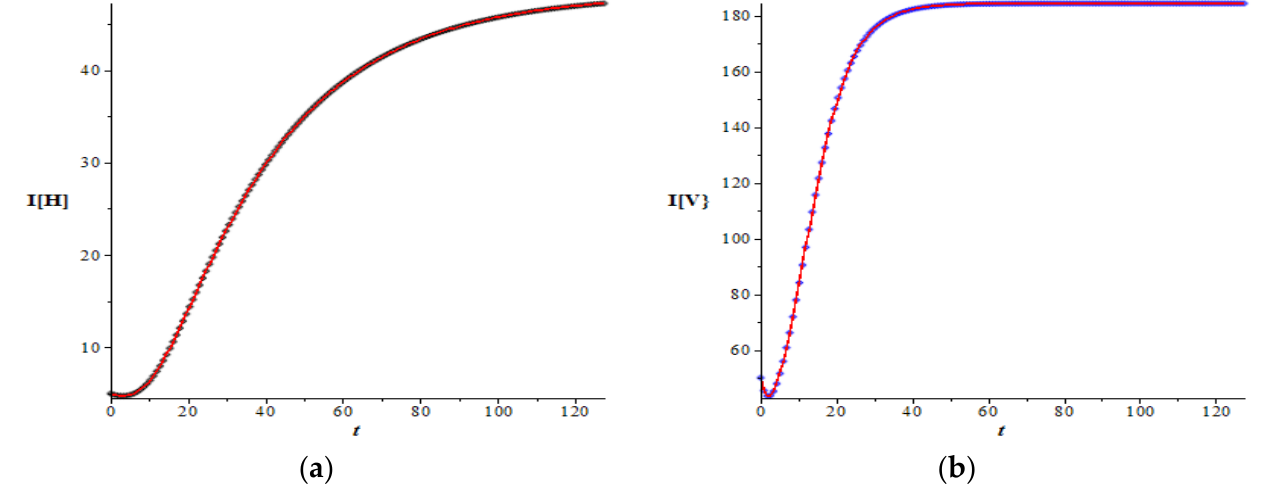
Figure 7. ( a ) shows the graphs of I H ( t ) , while ( b ) shows the graphs of I V ( t ) . Here we use the data set which gives a large basic reproduction number, i.e., R 0 = 41.580 (without the presence of vaccination).